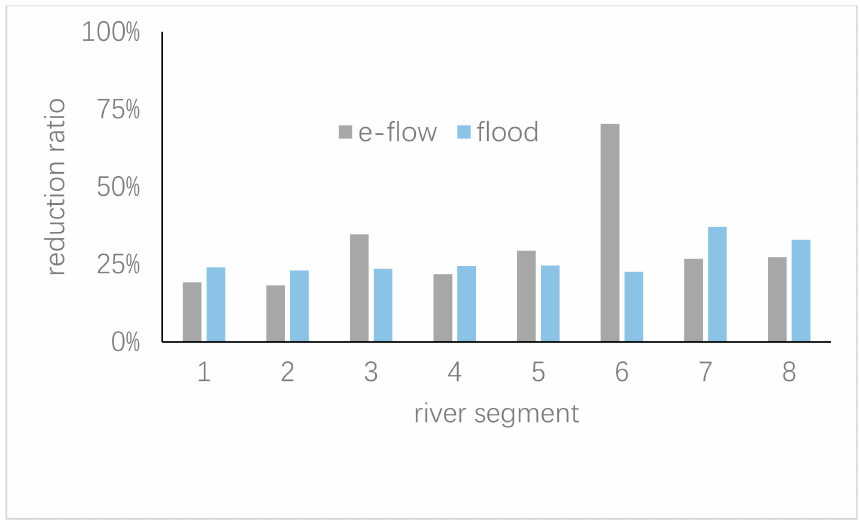
Figure 2. Comparison of reduction ratios between e-flow requirement and flood control ability under the high hydrological connectivity scenario (specific flow velocity = 0.1 m / s) with a siltation depth equal to 0.5